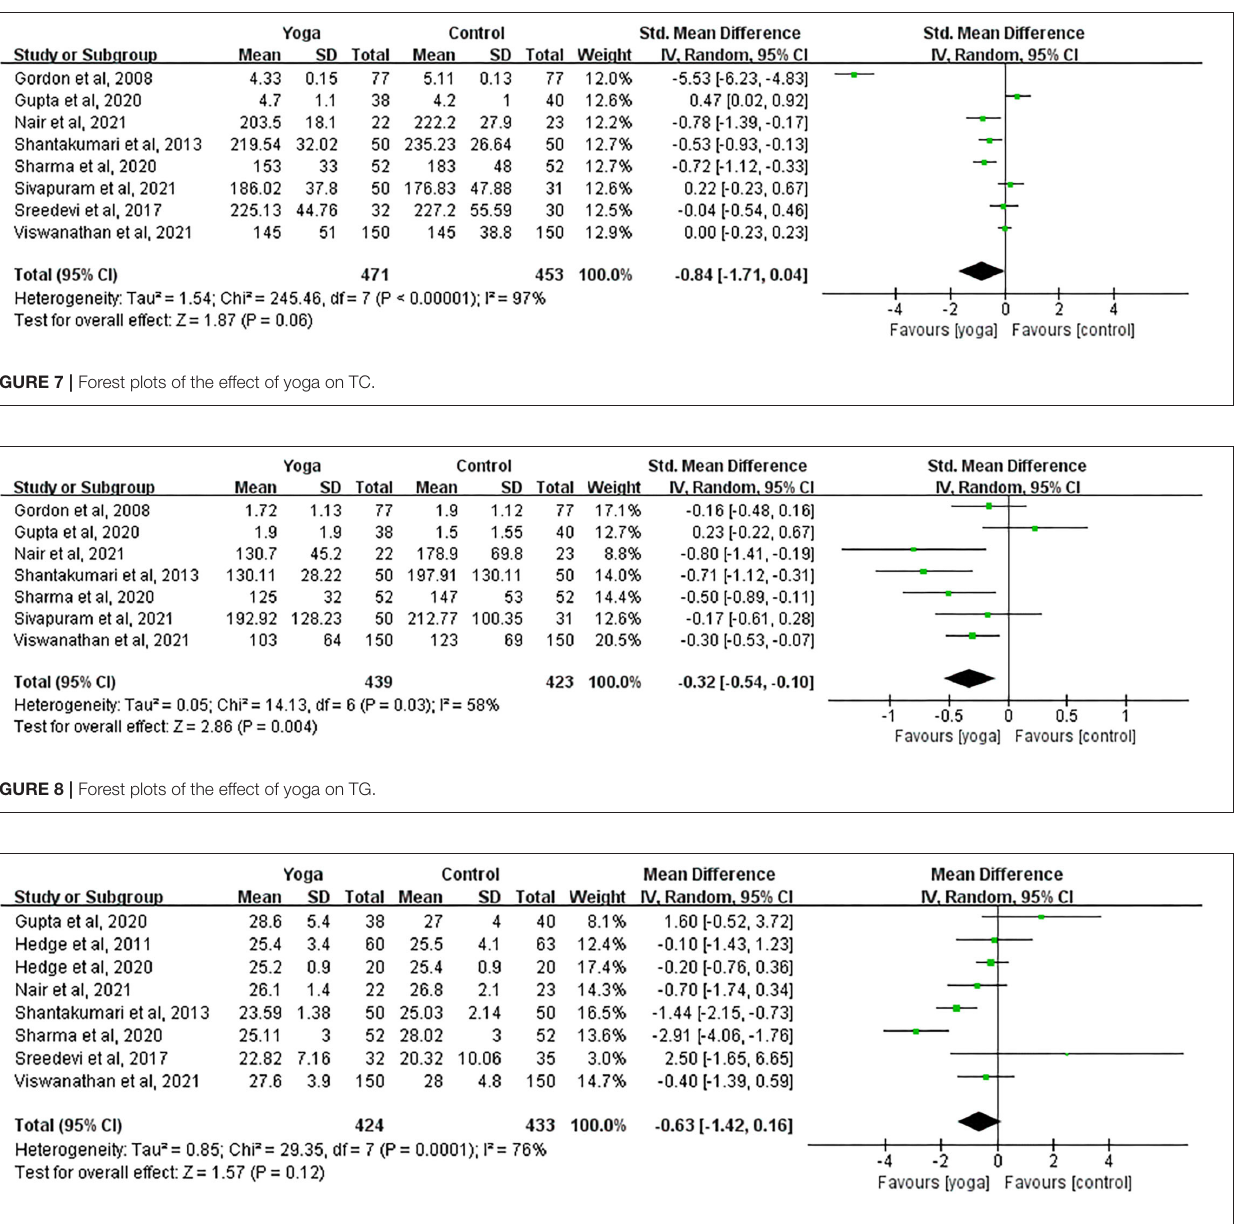
FIGURE 9 | Forest plots of the effect of yoga on